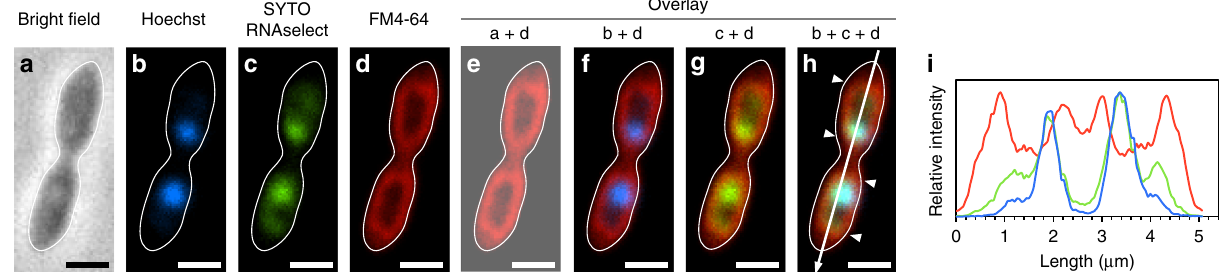
Fig. 2 Confocal-laser microscopy showing the localization of DNA and RNA within the intracytoplasmic membrane structure. DNA, RNA, and membrane lipids were stained by Hoechst (blue), SYTO RNAselect (green) and FM4-64 (red), respectively. Outlines of the cell from a are included in all panels. a Phase contrast image. b – d Confocal-laser images. e – h Image overlays. i Line pro fi les of fl uorescence intensity plotted longitudinally along white arrow in h . Membrane staining maxima are indicated by arrowheads in h . Source data are provided as a Source Data fi le. Scale bars, 1 μ